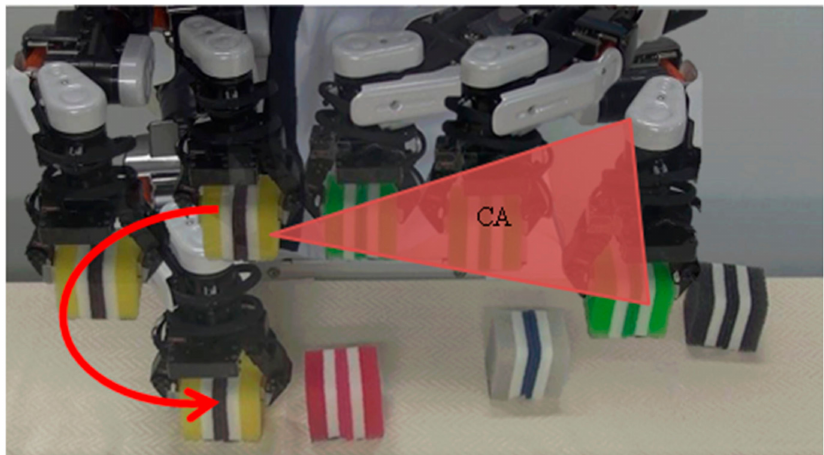
Figure 10. Collision avoidance in Experiment 2: The path indicated by the red arrow, avoids the CA, and carries the object.